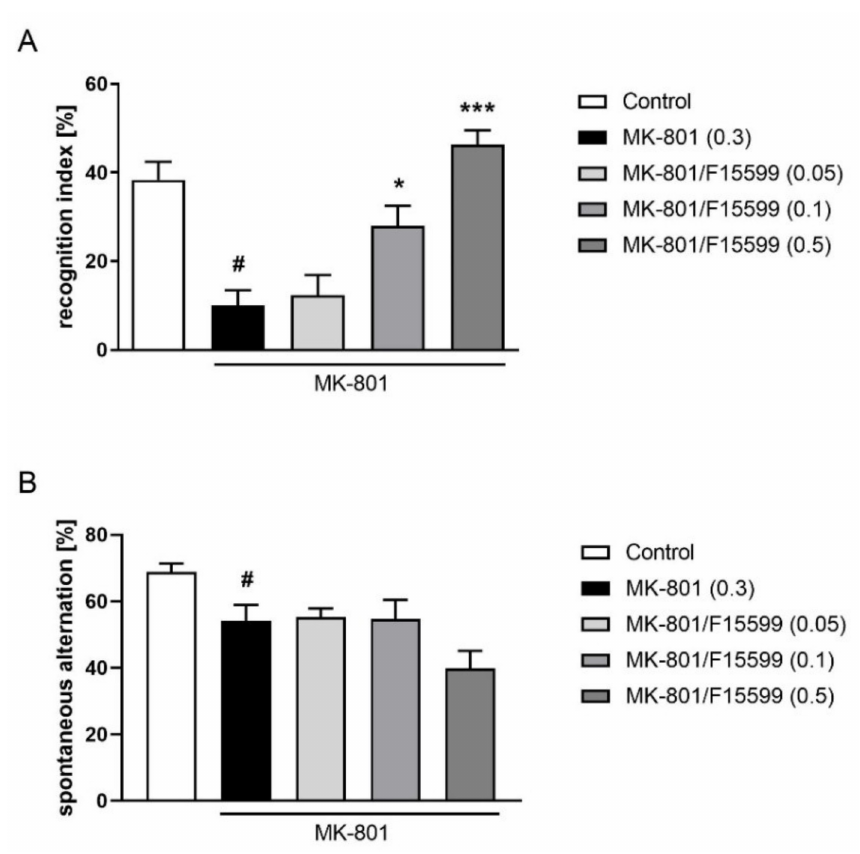
Figure 3. Activity of F15599 in the NOR ( A ) or Y-maze ( B ) test. The data are presented as means ± SEM. Doses of the compounds are indicated in parentheses. # p < 0.001 ( A ) or # p < 0.01 ( B ) compared to control animals and * p < 0.05, *** p < 0.001 compared to MK-801-treated